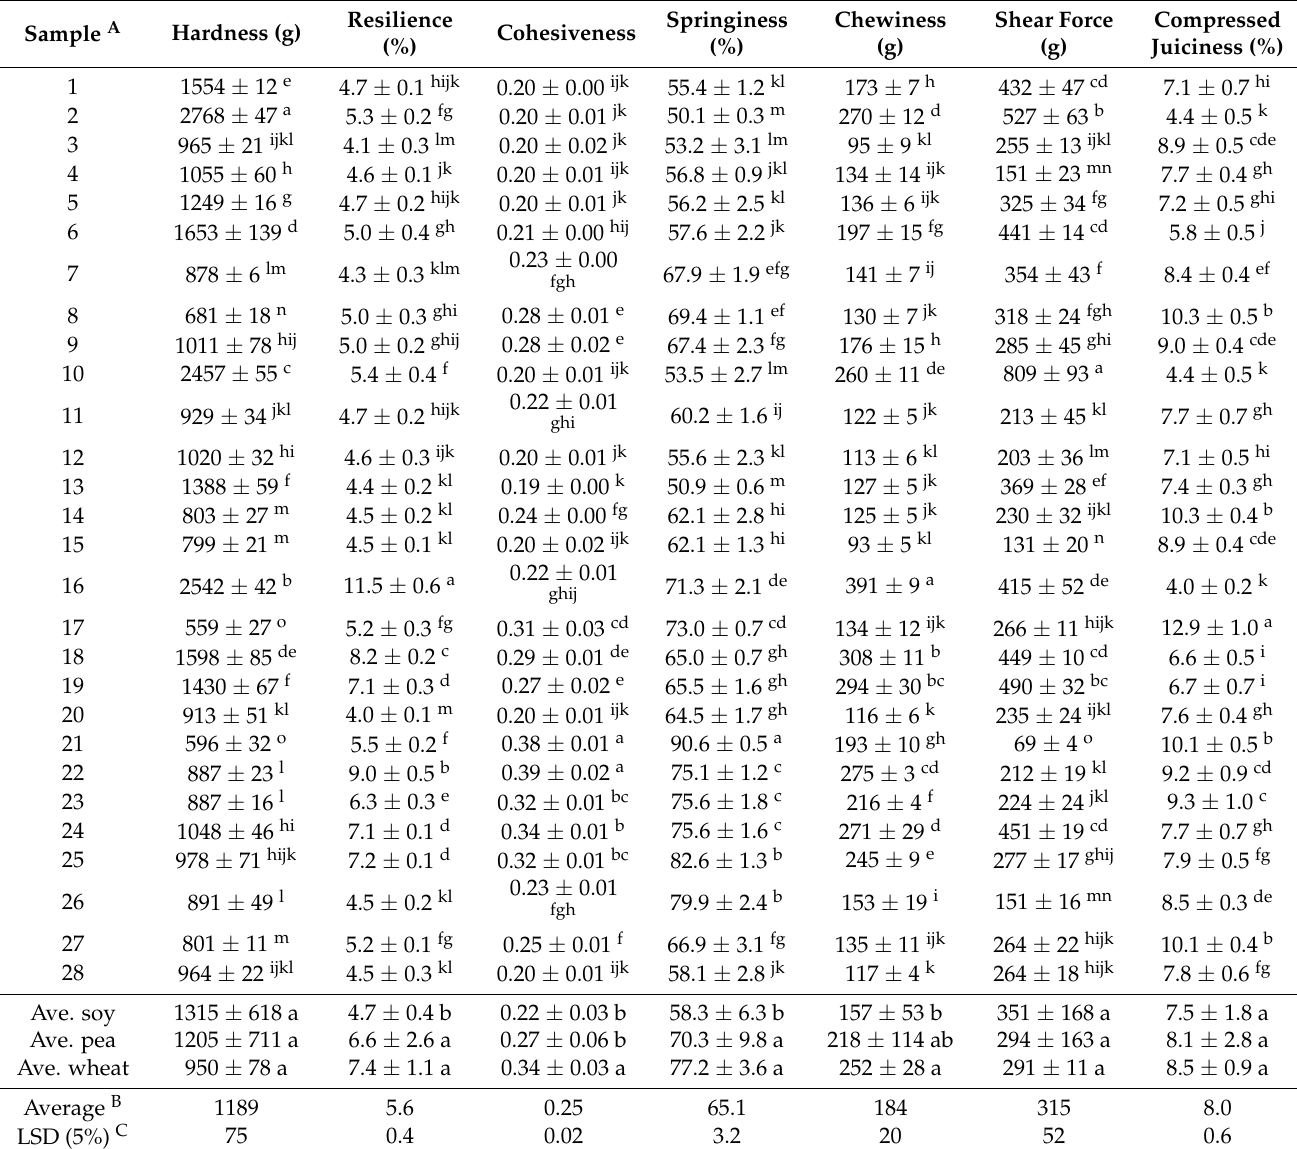
A Protein types of samples: 1–14 (soy protein), 15–21 (pea protein), 22–25 (wheat gluten), 26 (chickpea protein), 27 (pea and chickpea protein mixture), 28 (pea and navy bean protein mixture). Means with different superscript letters within the same column are significantly different ( p < 0.05) among samples 1–28. Different lowercase letters indicate significant difference among means of soy, pea and wheat gluten samples within the same column ( p < 0.05). B,C Average values of all samples and least significant difference (LSD) for comparison of different